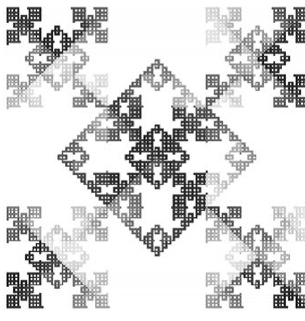
Fig. 2 Artistic design of fractal image illustration with improved